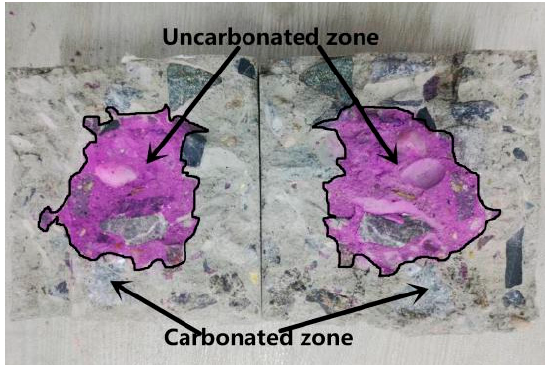
Figure 2. Cross section of the prepared specimen for measuring the carbonation depth. Table 4. Carbonation test results of concrete specimens.